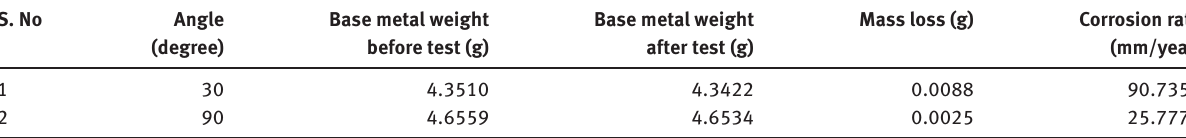
Table 2: Erosion and corrosion rate of substrate (base metal) material (cast NAB alloy). S.